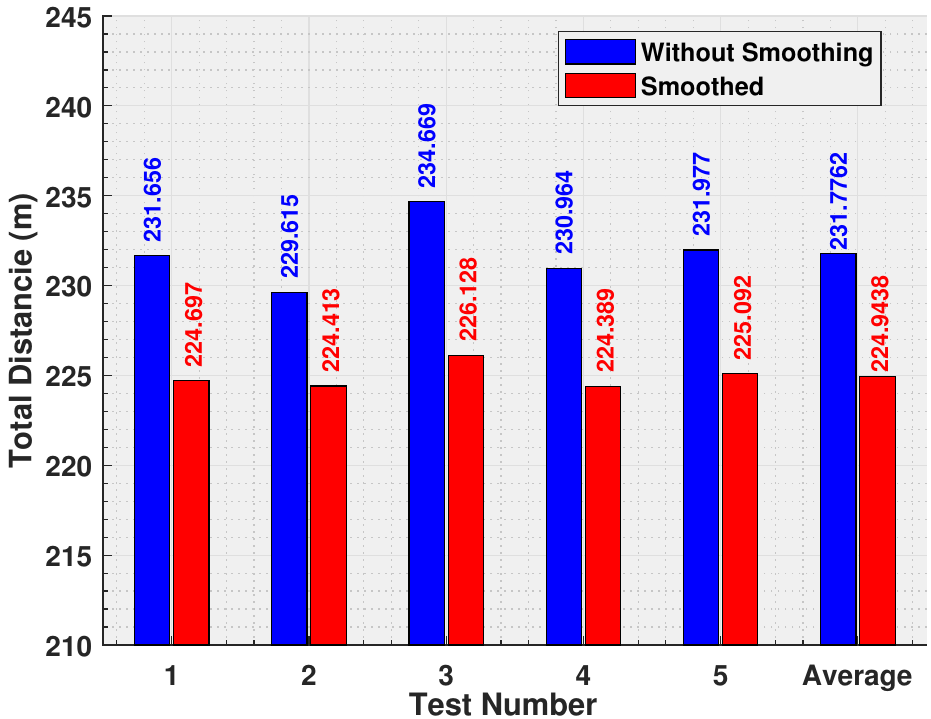
Figure 11. Comparison of the total distance traveled by a swarm of 5 UAVs for original paths and 3D smoothed